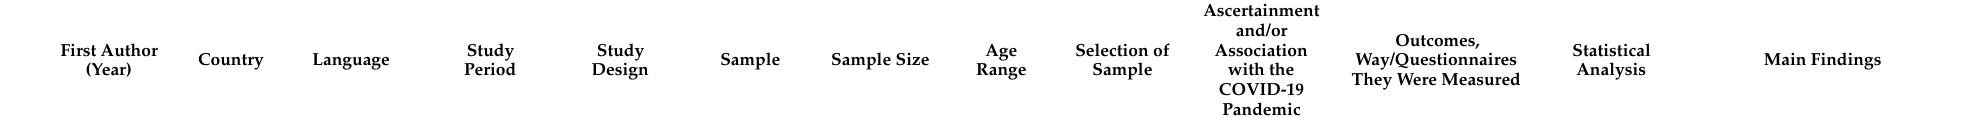
Table 1. Description of studies examining sexual health in adolescents and young adults during the COVID-19